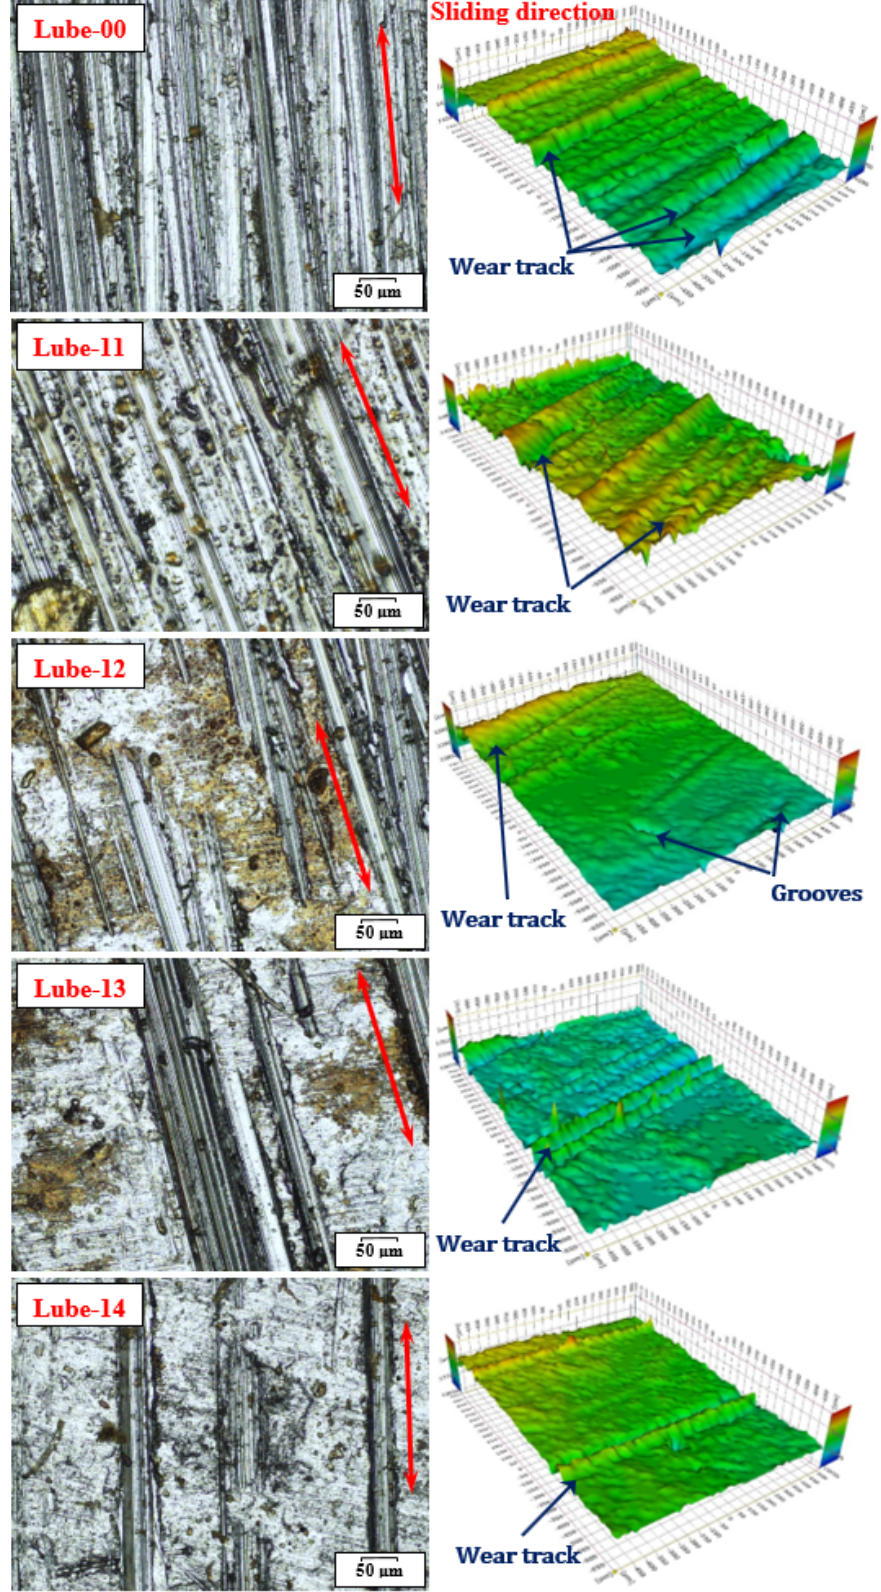
Figure 8. Micrographs of worn surface of samples (Lube-00, Lube-11, Lube-12, Lube-13, and Lube-14) with various loading contents of Al 2 O 3 NPs and 0.5 wt.% MWCNTs at different speeds and temperatures.